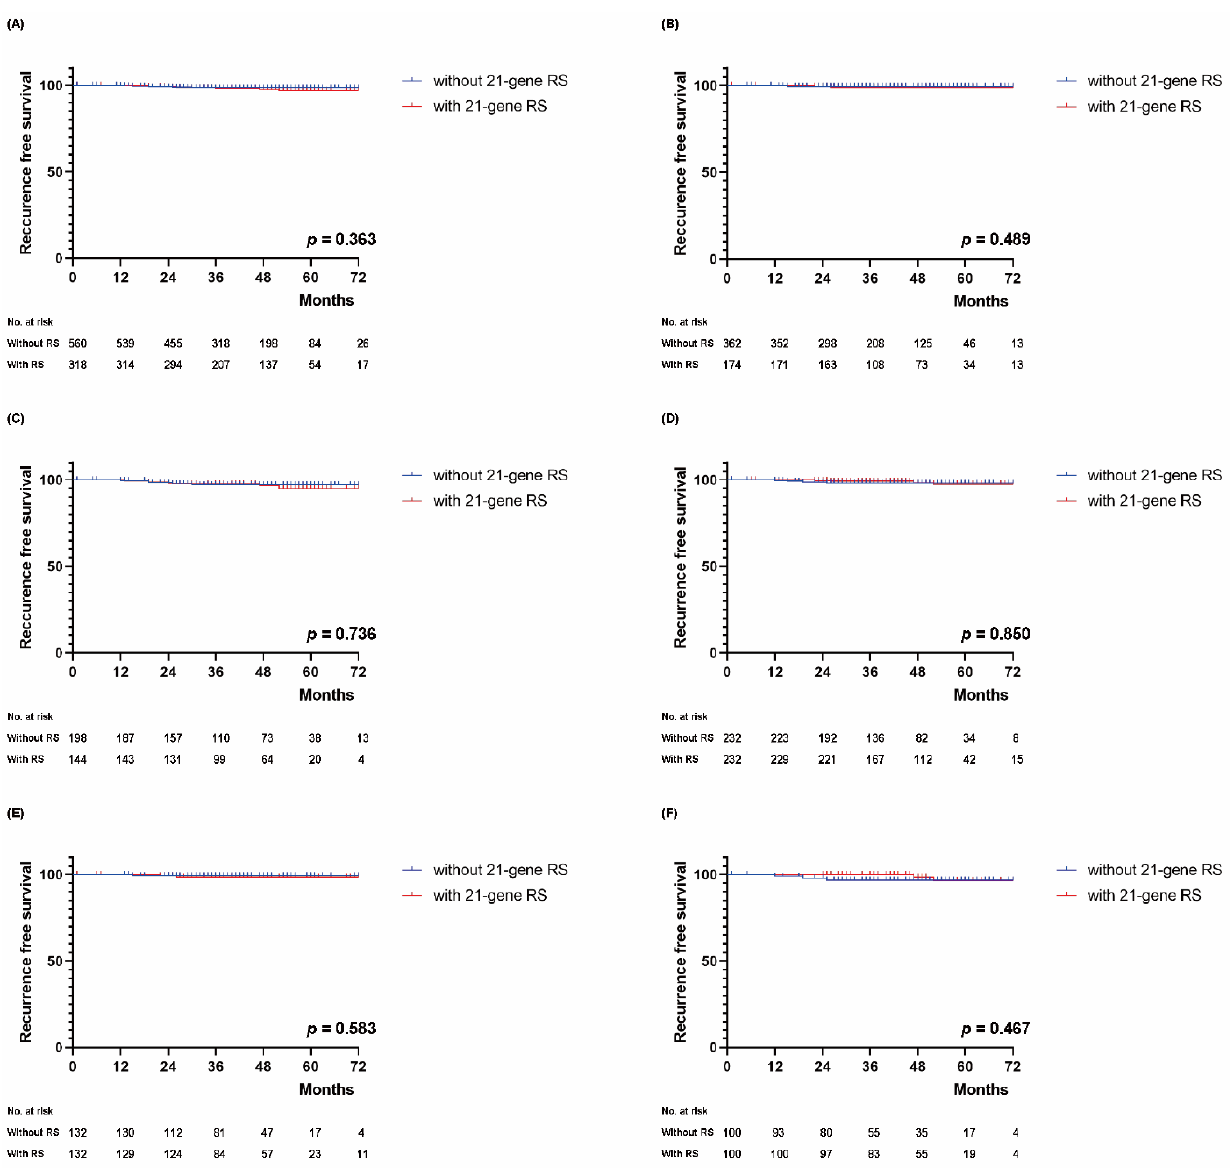
Figure 4. Recurrence-free survival (RFS) according to the application of the 21-gene Recurrence Score (RS) assay. Kaplan– Meier curves of RFS according to the application of the 21-gene RS ( A ) in all patients, ( B ) in all patients with low clinical risk, and ( C ) in all patients with high clinical risk, as well as ( D ) in the entire propensity-score matching (PSM) cohort, ( E ) in the PSM cohort with low clinical risk, and ( F ) in the PSM cohort with high clinical risk. Log-rank test, significance level of 0.05.